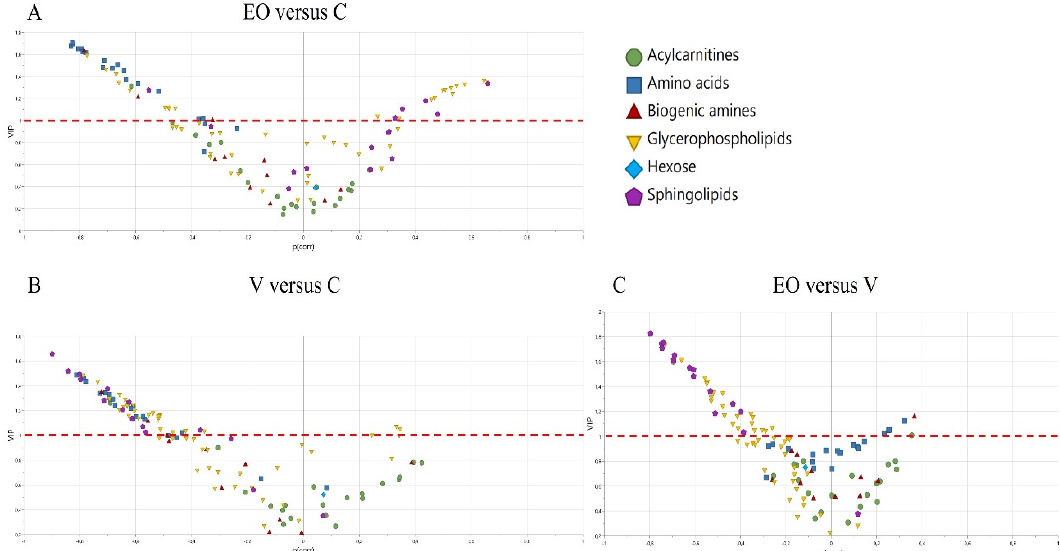
Figure 2. Volcano plot showing the contribution of each metabolite to the corresponding model according to the VIP and the p (corr) value. The metabolites with a negative p (corr) are decreased, and those with a positive p (corr) are increased. Each class of metabolites is represented by a symbol. All the results are globally represented in the Venn diagram (Figure 3), which shows